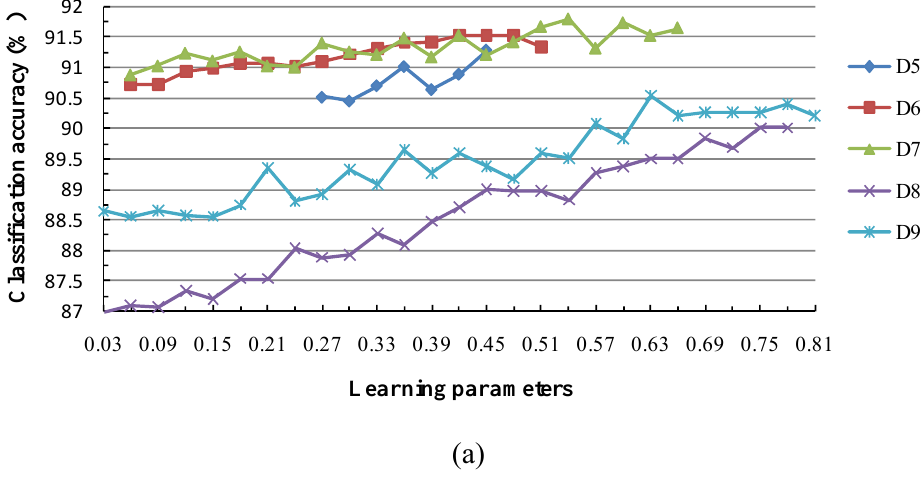
Learning parameters